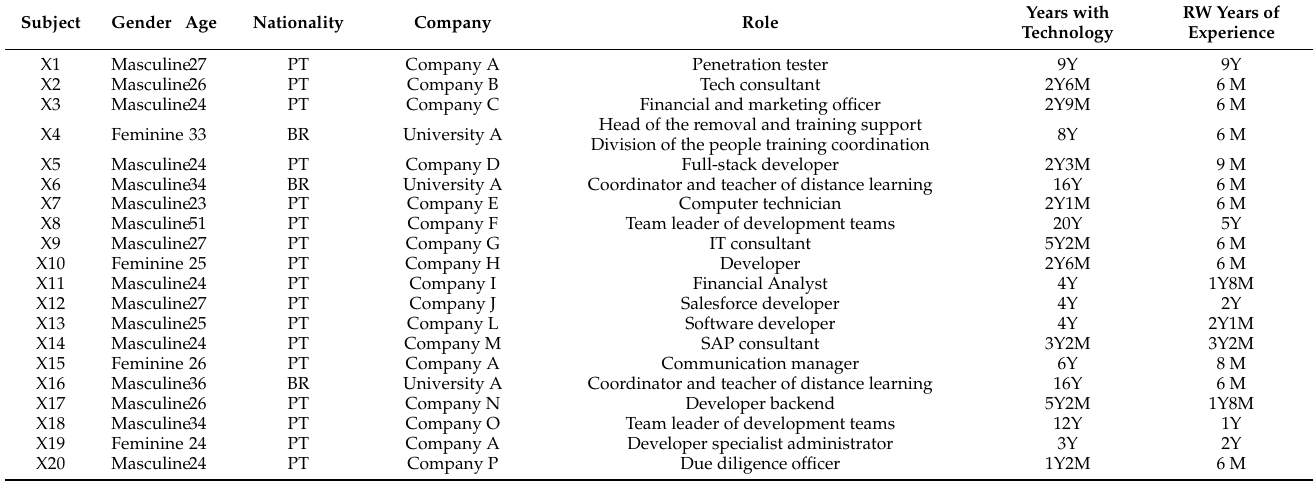
Table A1. Profile of